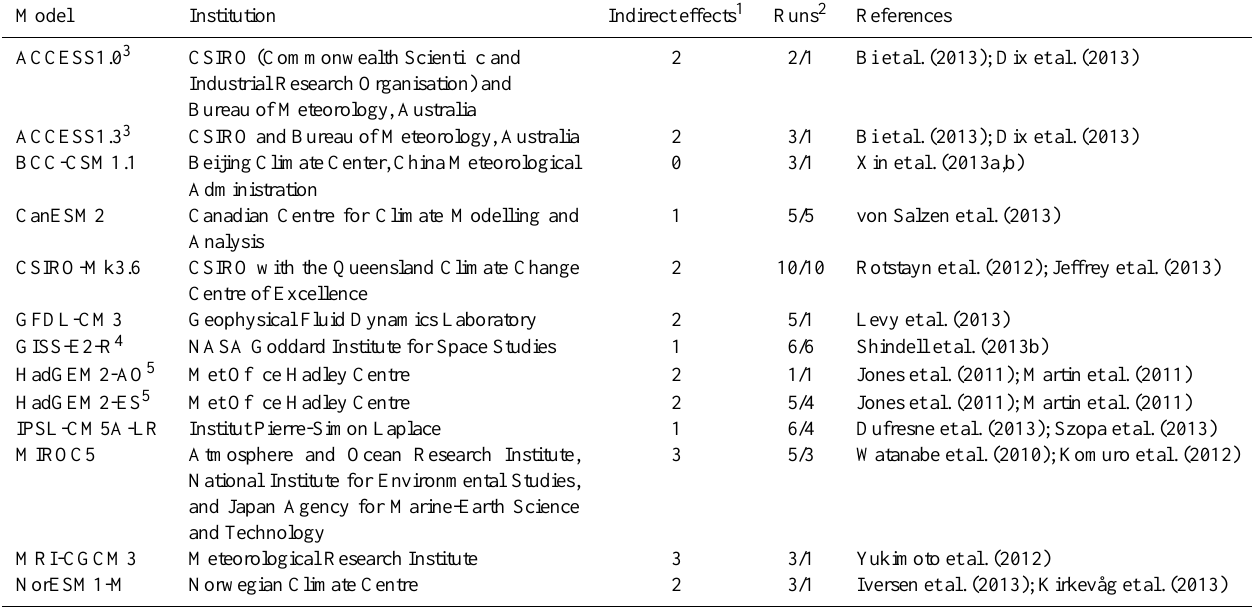
Table 1. Details of models used in Fig. 10 and subsequent